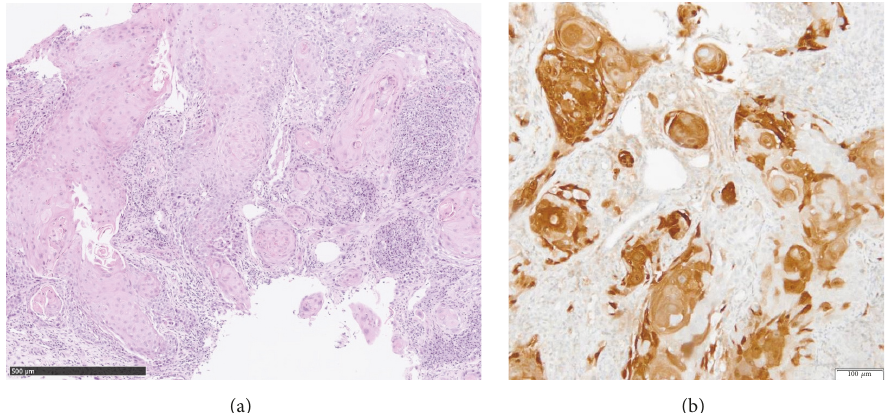
Figure 2: Microscopic aspect on biopsy, revealing moderately differentiated squamous cell carcinoma (a), with irregular/heterogenous positivity for p16 immunohistochemistry (b).